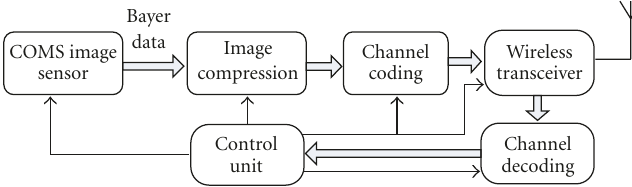
Figure 1: Block diagram of system architecture inside wireless endoscopic capsule.